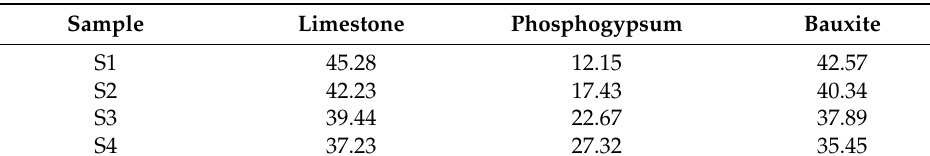
Table 3. Proportioning of the cement raw materials (wt.%).